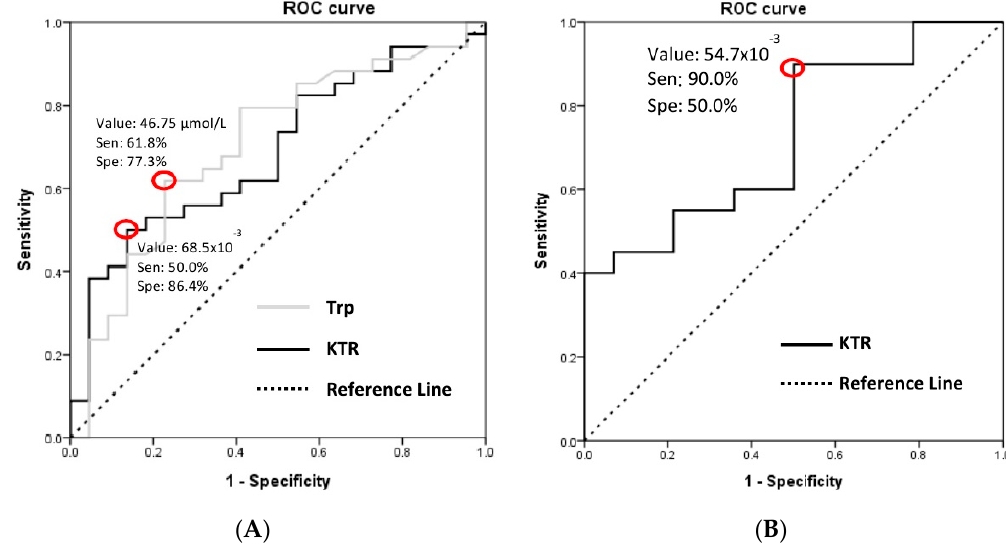
Figure 2. ROC curve analysis was carried out by SPSS (SPSS, Chicago, IL, USA) to determine the best discrimination point of ( A ) Trp (cut-off value 46.75 μ mol/L with sensitivity 61.8% and specificity 77.3%, AUC = 0.704 with 95% CI 0.562–0.846, p = 0.011, SD = 0.073) and KTR (cut-off value 68.5 × 10 − 3 with sensitivity 50.0% and specificity 86.4%, AUC = 0.687 with 95% CI 0.547–0.827, p = 0.019, SD = 0.071) for predicting MAU. ( B ) KTR for ARB responsiveness in diabetic patients with MAU (cut-off value 54.7 × 10 − 3 with sensitivity 90.0% and specificity 50.0%, AUC = 0.729 with 95% CI 0.558–0.899, p = 0.025, SD = 0.087). ROC, receiver operating characteristic; Trp, tryptophan; KTR, kynurenine to tryptophan ratio; ARB, angiotensin receptor blocker; AUC, area under the ROC curve; 95% CI, 95% confidence interval; SD, standard